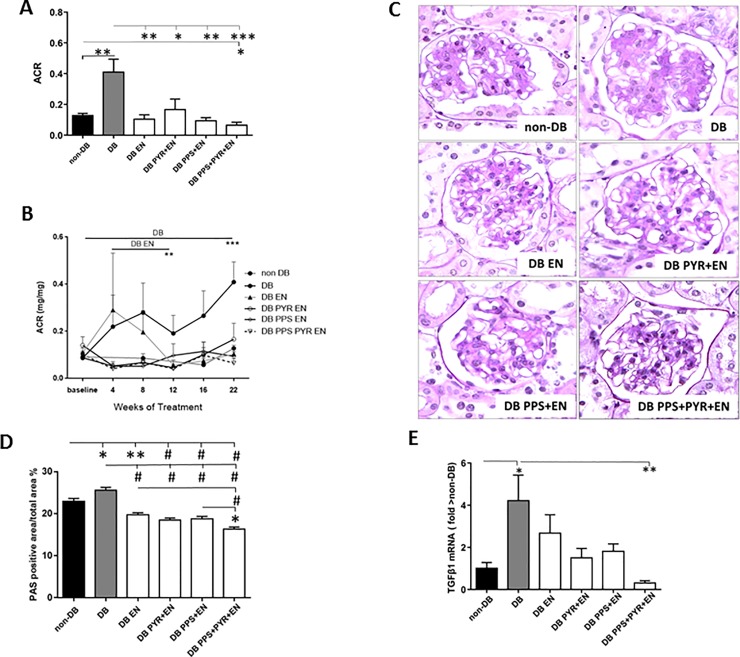
A) Albumin to creatinine ratio (ACR) at sacrifice (22 weeks). B) ACR follow-up for 22 weeks. C) Periodic acid–Schiff (PAS) staining: a) non-DB, b) DB, c) DB EN, d) DB PYR+EN, e) DB PPS+EN, f) DB PPS+PYR+EN. D) Morphometric evaluation of glomerular PAS positive areas. E) Kidney TGFβ1 mRNA levels. *p<0.05; **p<0.01; ***p<0.005; #p<0.001. DB, diabetics; EN, enalapril; PPS, pentosan polysulfate; PYR, pyridoxamine; PAS, periodic acid–Schiff; TGFβ1, transforming growth factor β1.